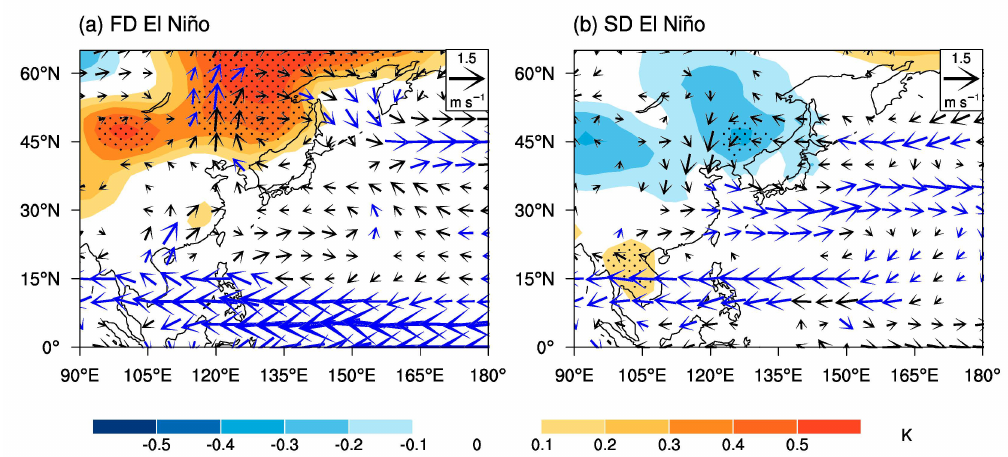
Figure 7. Same as Figure 2 but for the surface air temperature anomalies (shaded) and 850 hPa wind anomalies (vectors) in